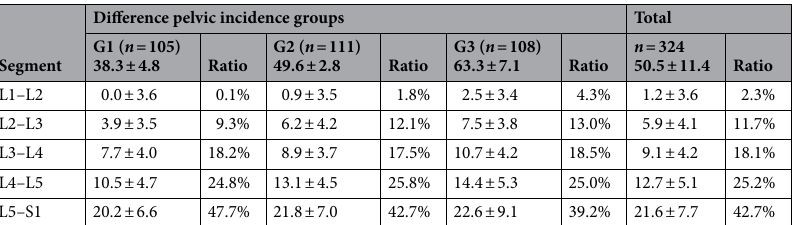
Table 2. Segmental lumbar spine lordosis for the pelvic incidence groups. G1: pelvic incidence < 45°; G2: pelvic incidence between 45° and 55°; G3: pelvic incidence > 55°.